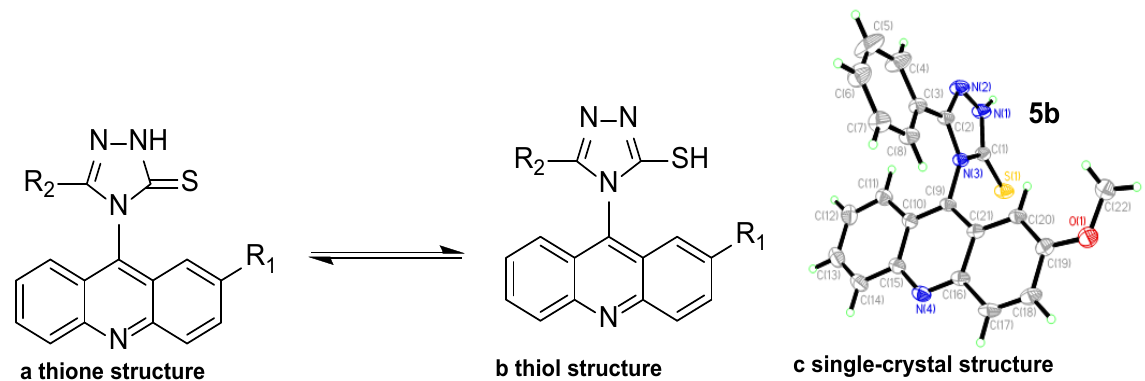
Figure 3. The molecular structure of compound 5b.